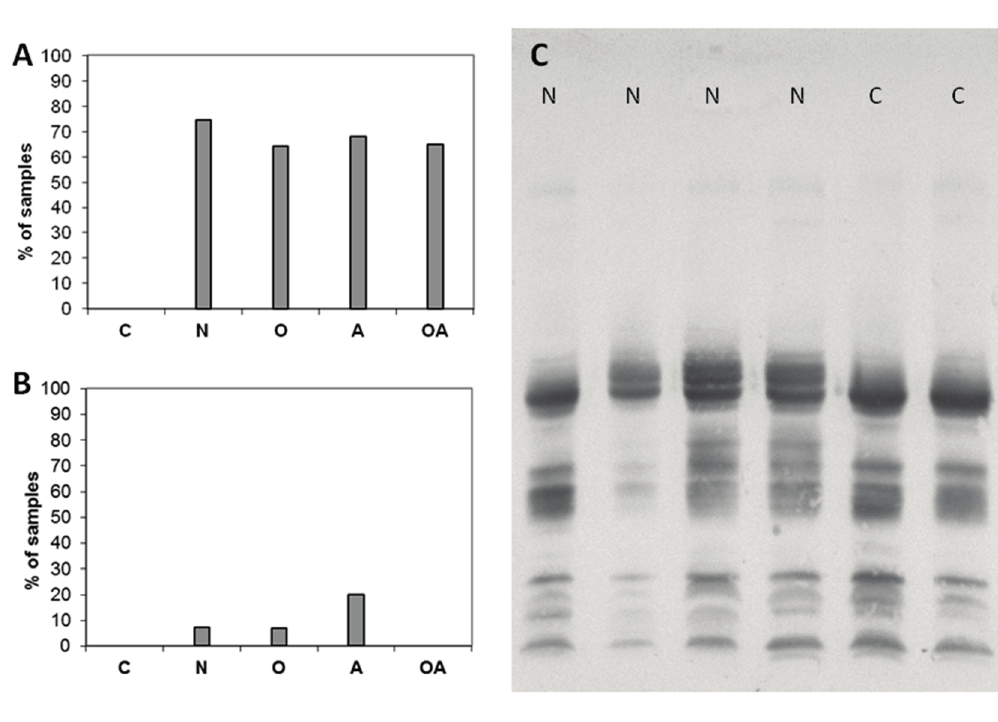
Figure 4. Altered patterns of GNL-reactive glycoproteins. ( A ) Percentage of samples with increased number of GNL-reactive bands <20 kDa; ( B ) Percentage of samples with abundant GNL-4 band of increased mass in PSA band; ( C ) Reactivity of seminal plasma